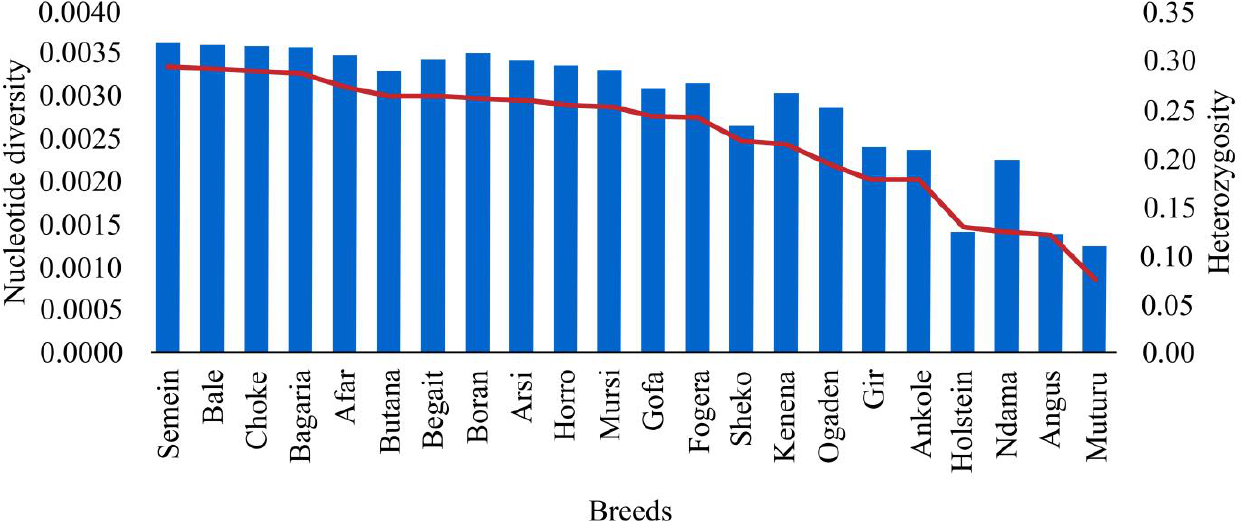
Figure 4. Nucleotide diversity (blue bar) and genomic heterozygosity (red line) of Ethiopian and non- Ethiopian cattle populations.